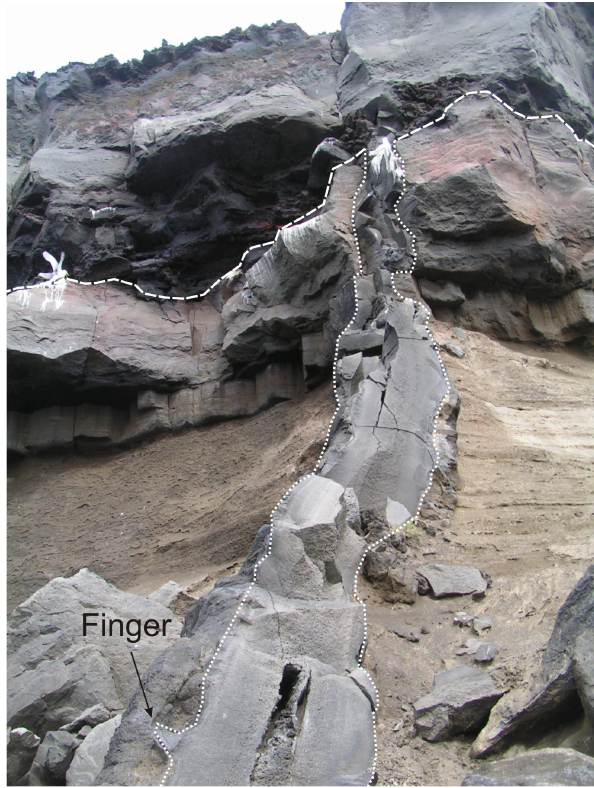
Fig. 5. The Reykjanes dyke (Iceland) feeding a lava flow. The dyke dissects soft pyroclastic layers and then, at the top, a stiff basaltic lava flow. The stiffening of the host rocks may be the cause of the decreasing of dyke thickness upwards towards the vent. The dashed line indicates the